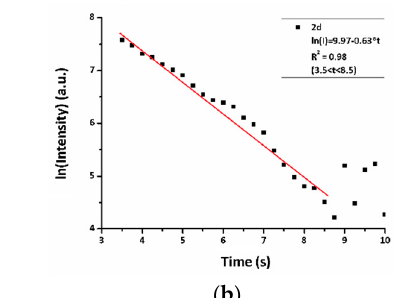
Figure 3. Fluorescence spectra of ( a ) 2b ( λ ex = 303 nm) and ( c ) 2d ( λ ex = 325 nm) (30 μ M) with the addition of various concentrations of CuCl 2 in HEPES/DMSO buffer and the corresponding titration curves and linear ranges of ( b ) 2b and ( d ) 2d.